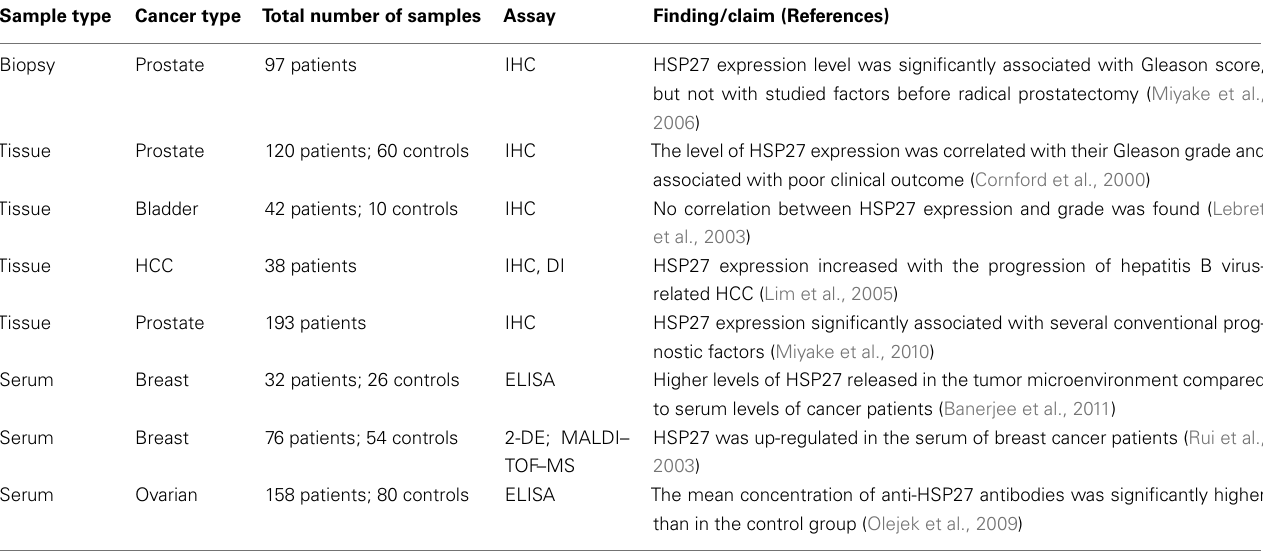
Table 1 | Selection of recent publications assessing HSP27 as a biomarker in cancers. Sample type Cancer type Total number of samples